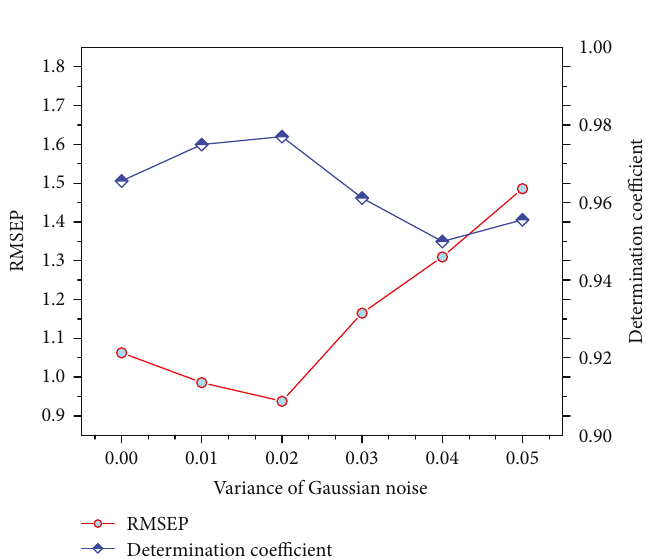
Figure 10: In fl uence on the model of Gaussian noise with di ff erent